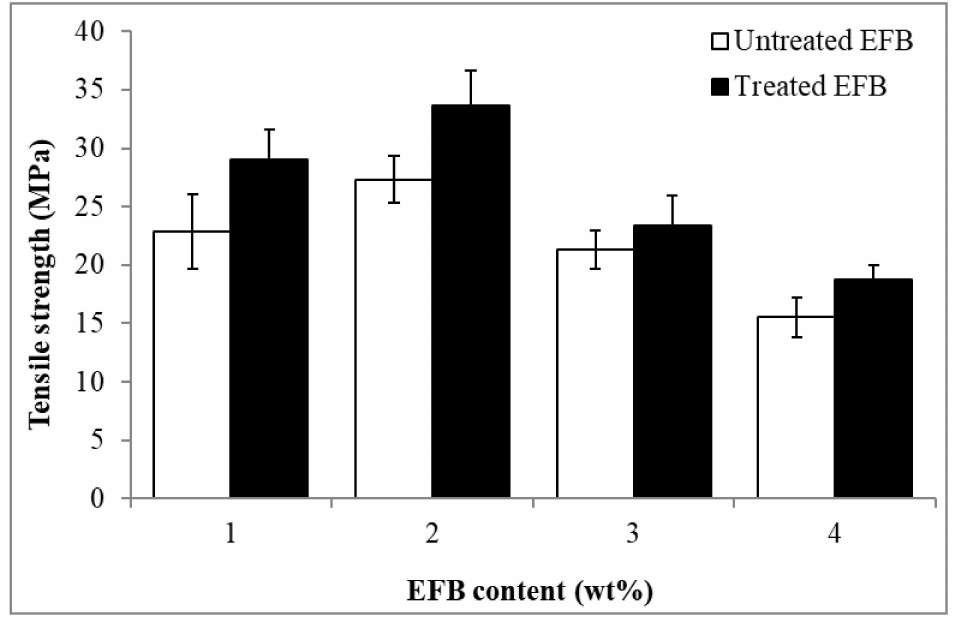
Figure 2. E ff ect of EFB content on tensile strength of untreated and MMA-treated EFB RC biocomposite